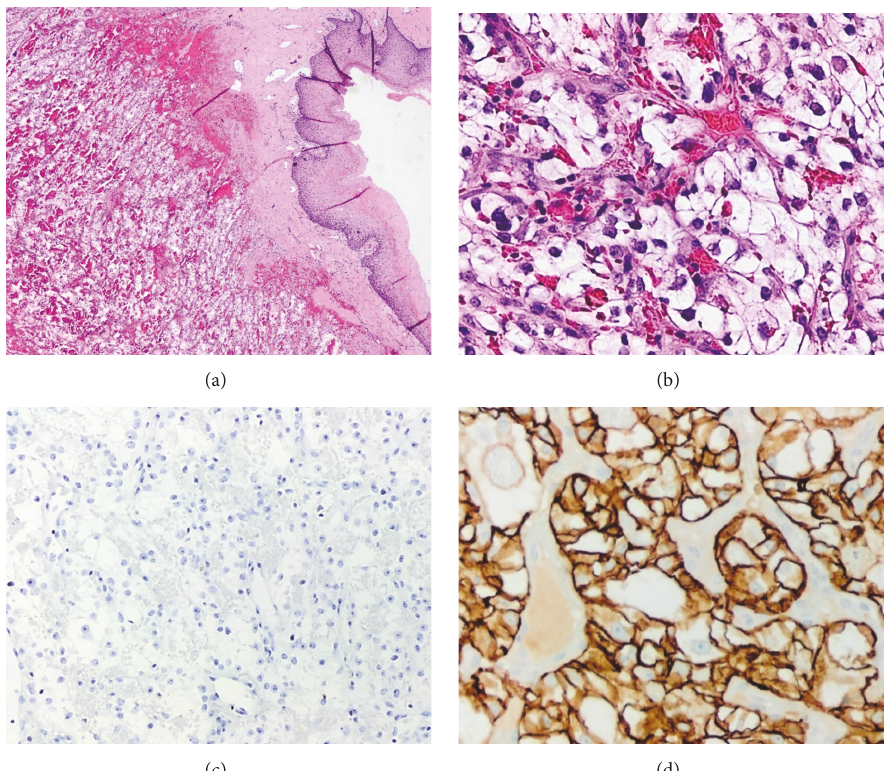
Figure 1: Histology of initial vaginal mass. (a) Vaginal nodule showing neoplastic cells with abundant clear cytoplasm and characteristic delicate vascular network (H&E, × 20). (b) High power view of the vaginal lesion revealed a clear cell carcinoma (H&E, × 200). (c) Neoplastic